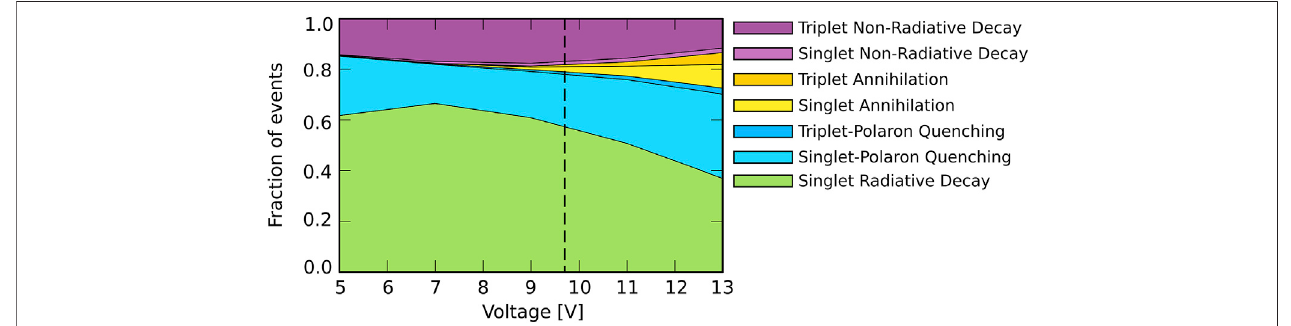
FIGURE 4 | Relative contribution of the various excitonic processes for singlets and triplets with Förster processes between all materials. The dashed vertical line represents the voltage that corresponds to J 0 (cid:2) 190 Am − 2 at which the degradation simulations are performed.